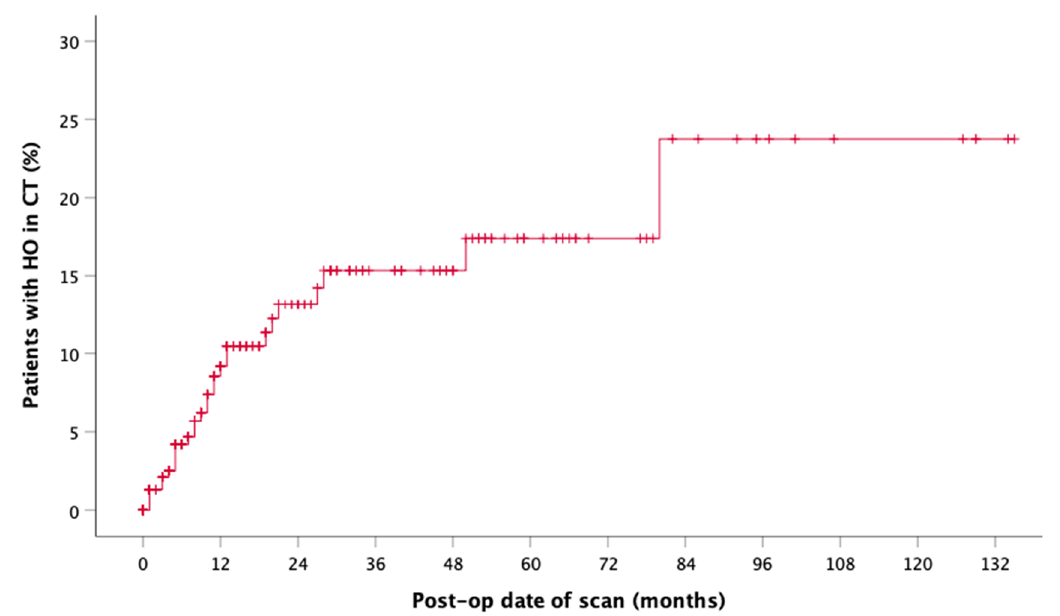
Figure 3. Incidence function shows the overall radiographic presence of HO aligned to the postoperative date of CT ( n = 29).